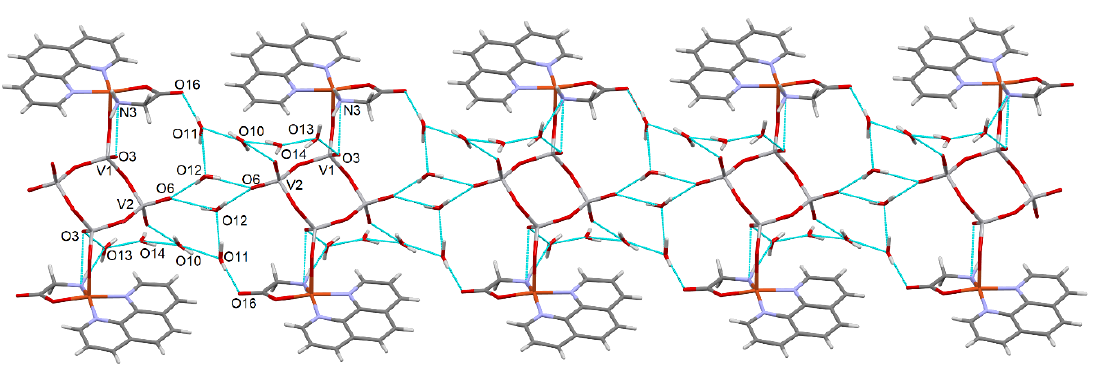
Figure 3. Capped stick representation of the hydrogen bond network that aligns all the